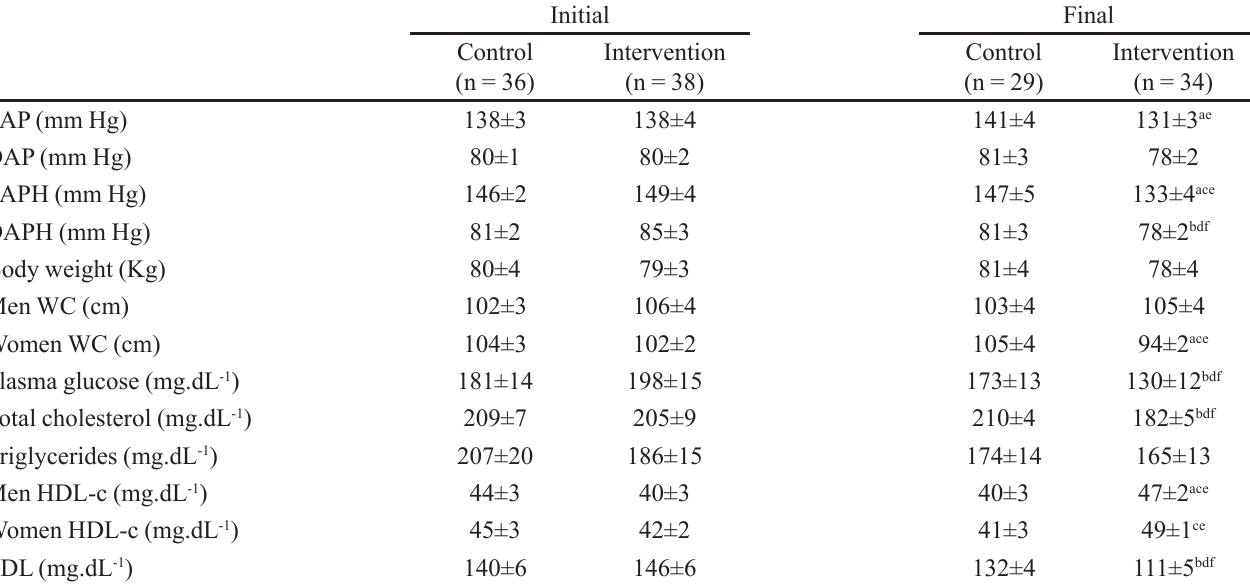
TABLE III – Values of SAP and DAP and anthropometric and biochemistry data of the Control and Intervention groups Initial